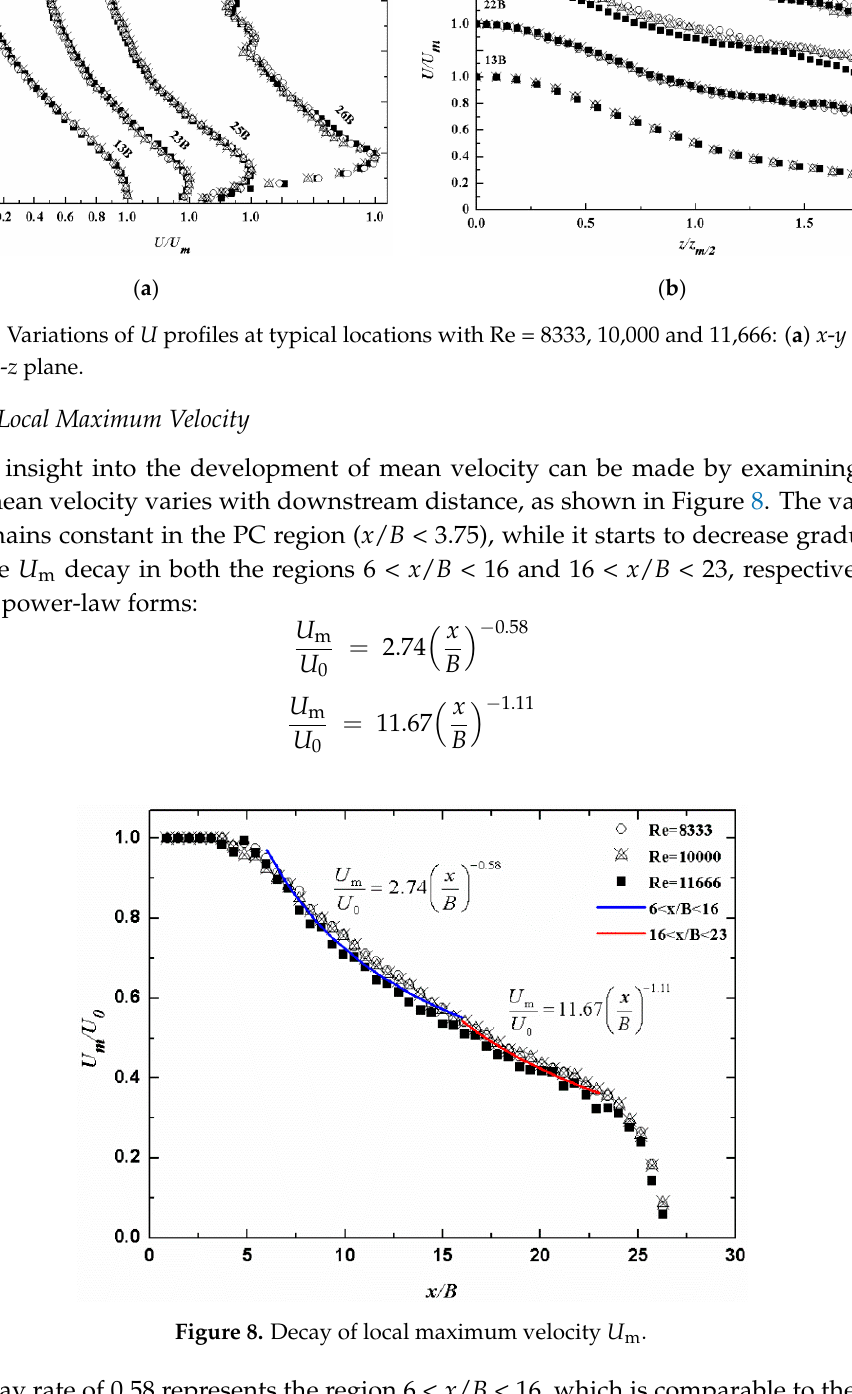
Figure 8. Decay of local maximum velocity U m .